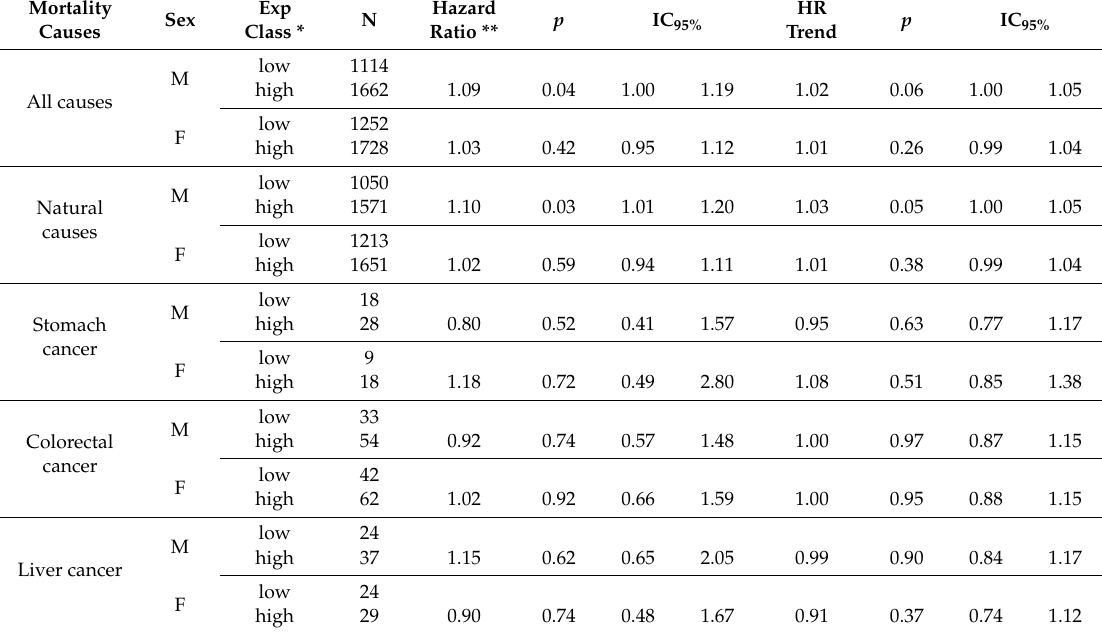
Table 2. 2001–2012 mortality associated with exposure to NO χ -MWI for